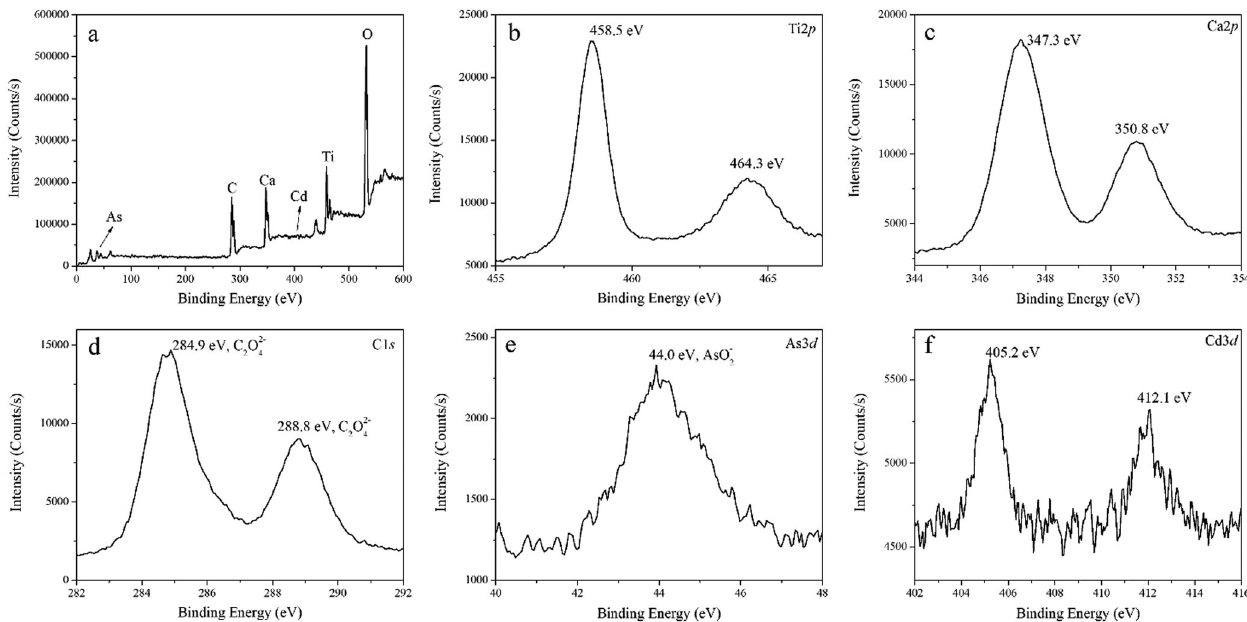
Fig. 7 XPS analysis of the fl oc formed during the coagulation process. ( a ) Full spectrum, ( b ) Ti2 p electron, ( c ) Ca2 p electron, ( d ) C1 s electron, ( e ) As3 d electron, ( f ) C d 3 d distributes homogeneously in both Ti-rich and Ca-rich area, indicating that CaC 2 O 4 and TiO(OH) 2 both contributes to the removal of Cd (Fig. 6 b, c and e). In a previous report, Cd 2 + was found coprecipitated together with Ca 2 + by forming (Ca,Cd)C 2 O 4 mixed crystal 58 . Therefore, the removal of As and Cd may possibly follow different mechanisms. As is removed mainly by surface adsorption of TiO(OH) 2 while Cd is removed by surface adsorption of TiO(OH) 2 and encapsulation of CaC 2 O 4 . XPS was used to analyze the elemental composition and chemical valence of the fl ocs (Fig. 7). The fl ocs mainly consisted of Ca, C, Ti, and O. As and Cd can also be observed in re fi ned spectra 57,59 . Ti